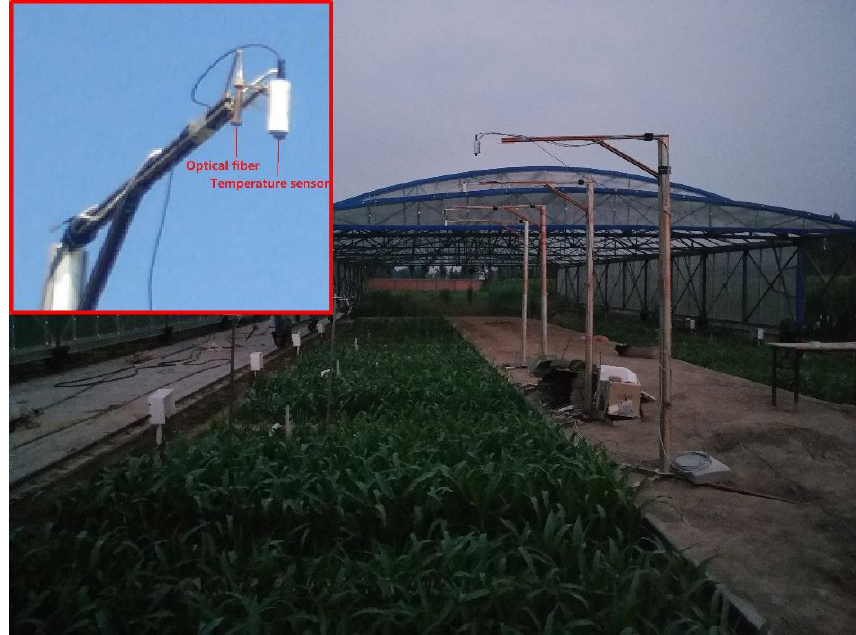
Figure 1. Experimental field area and automatic observation system.